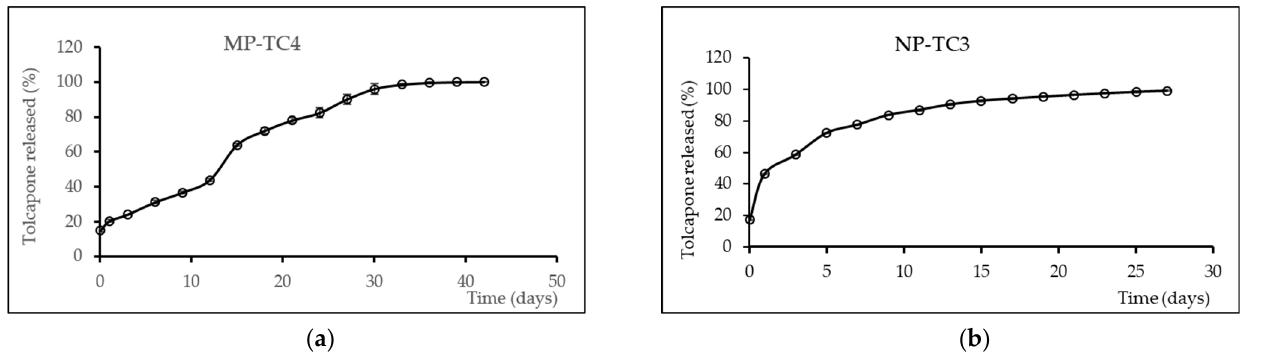
Figure 2. Mean release profiles (±SEM, n = 3) of TC from formulations MP-TC4 ( a ) and NP-TC3 ( b ). TC (tolcapone).